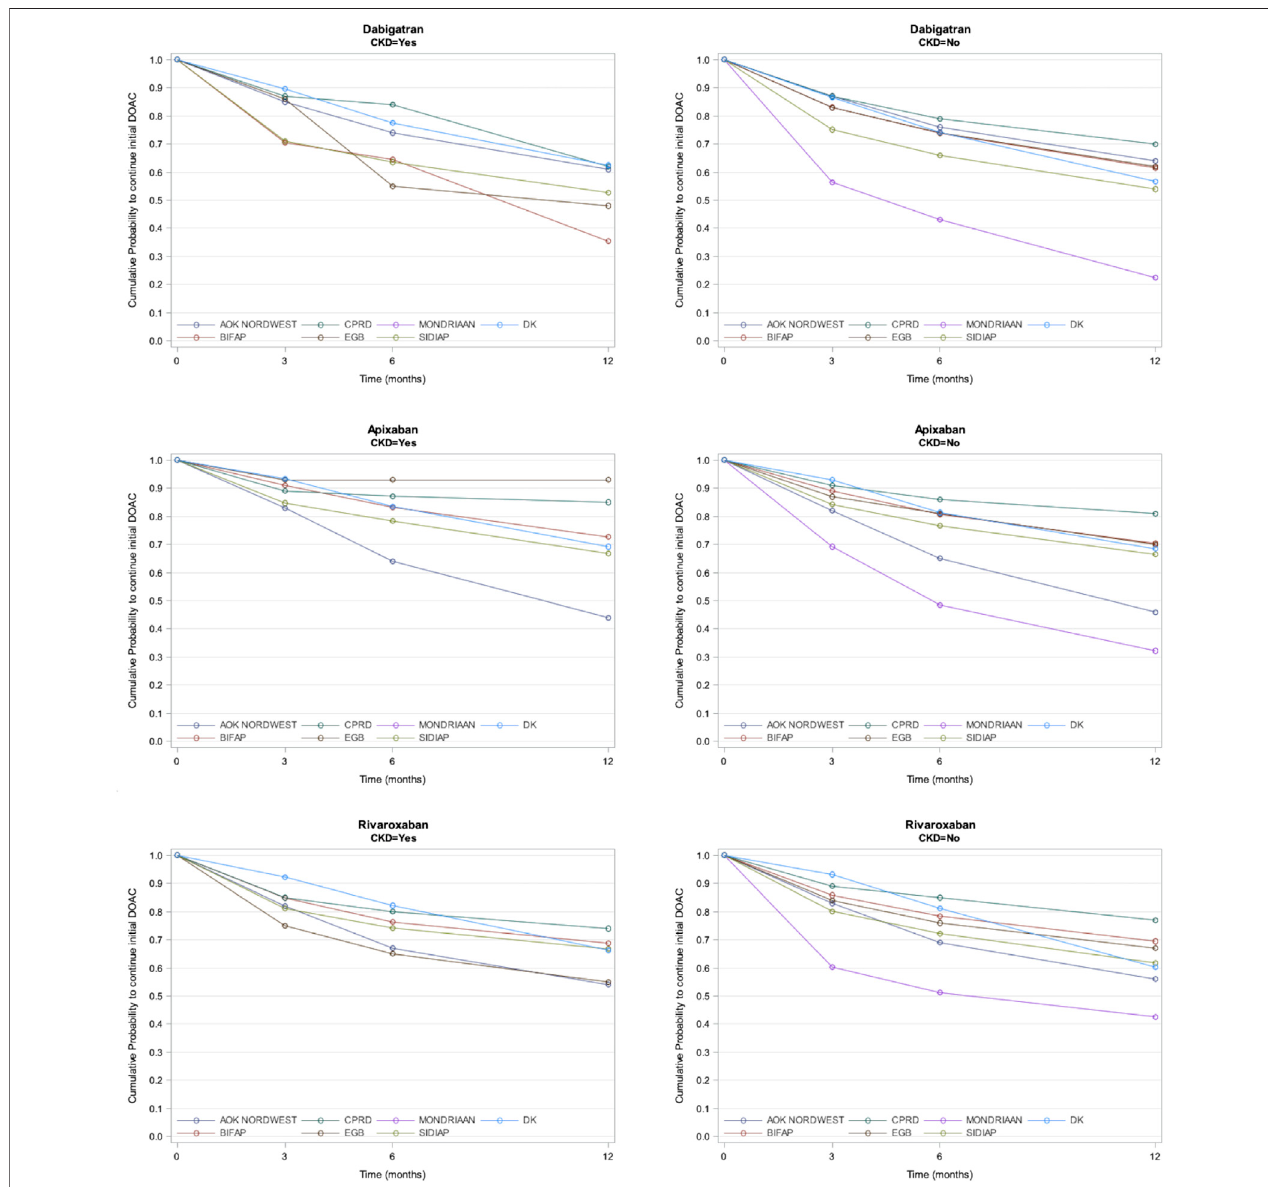
FIGURE 2 | Probability of Continuation of individual DOAC in each database and